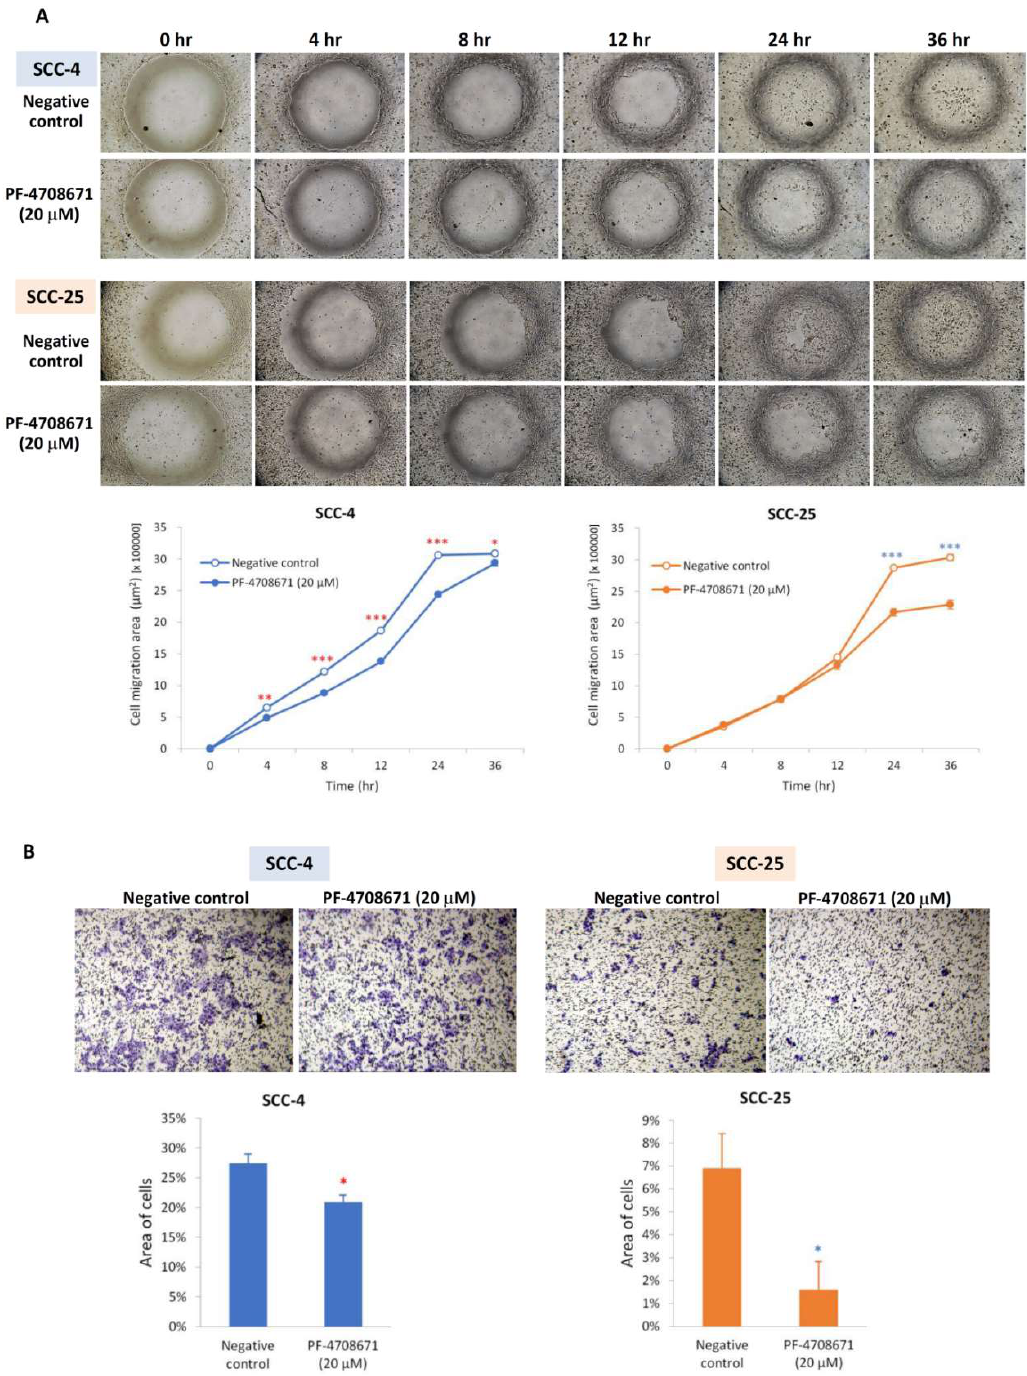
Figure 5. Phospho-p70S6K inhibitor (PF-4708671) inhibited the migratory and invasion activities of SCC-4 and SCC-25 cells. ( A ) Wound-healing assay revealed that SCC-4 and SCC-25 cells had shorter migration distances after PF-4708671 treatment. * p < 0.05, ** p < 0.01, and *** p < 0.001 indicate the statistical significance of the differences at one point in time between cells with and without treatment. ( B ) After incubating for 24 h (SCC-4) or 48 h (SCC-25) in transwell chambers, the area of migratory or invasive cells was markedly decreased in PF-4708671-treated cells compared with cells without treatment. * p < 0.05 indicates the statistical significance of differences between cells with and without treatment (red * for SCC-4 and blue * for SCC-25).